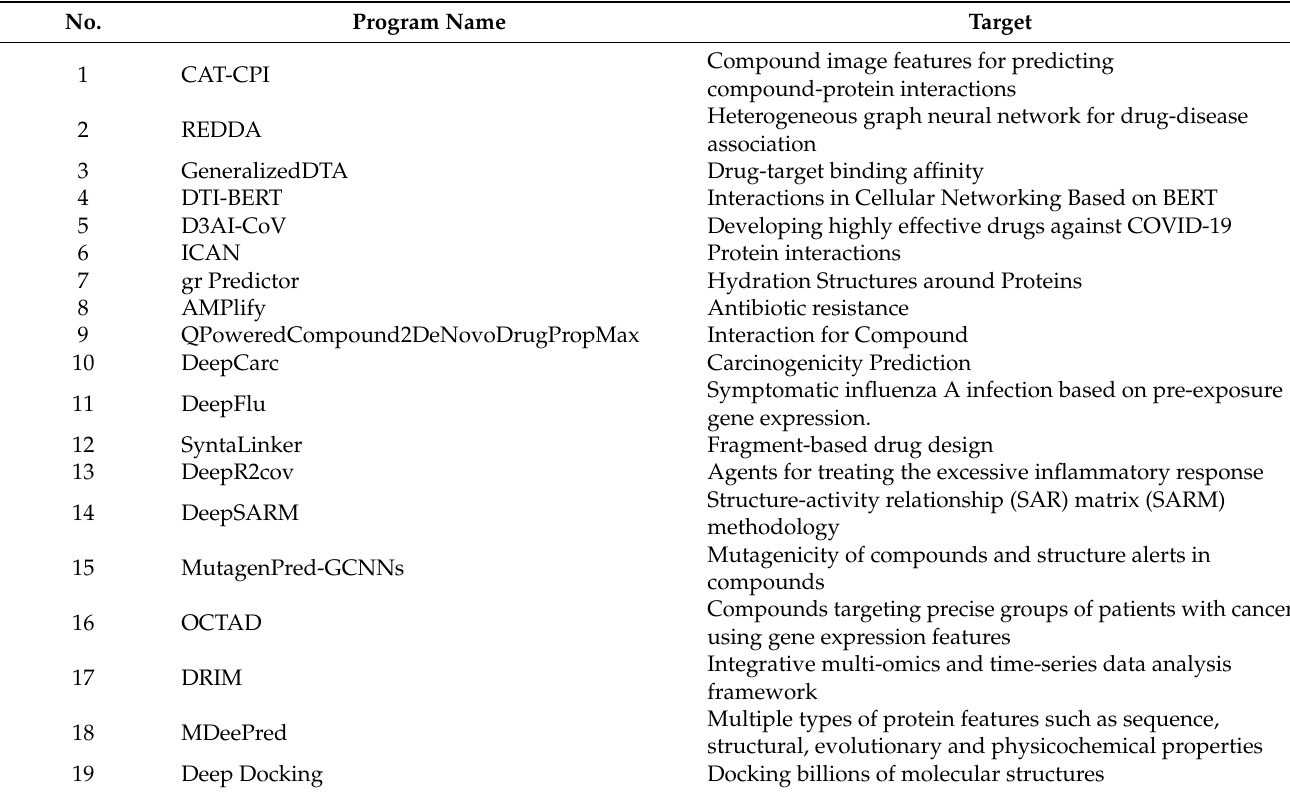
Table 1. Deep learning based drug discovery